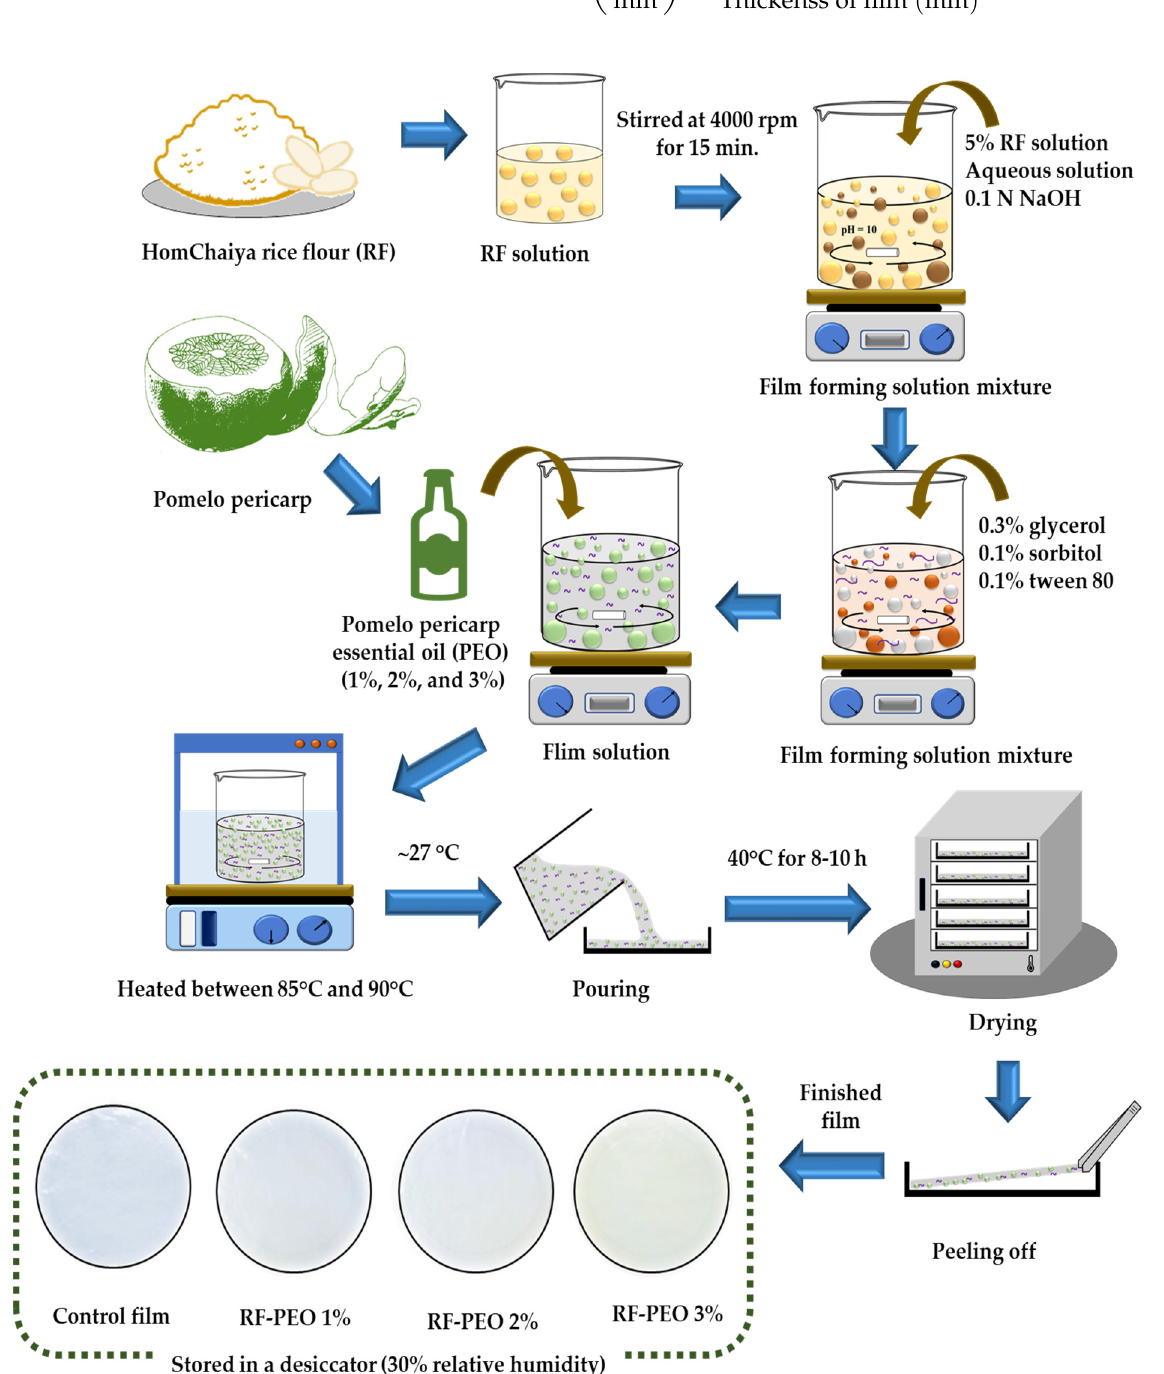
Figure 1. Schematic representation of RF-PEO edible fi lm